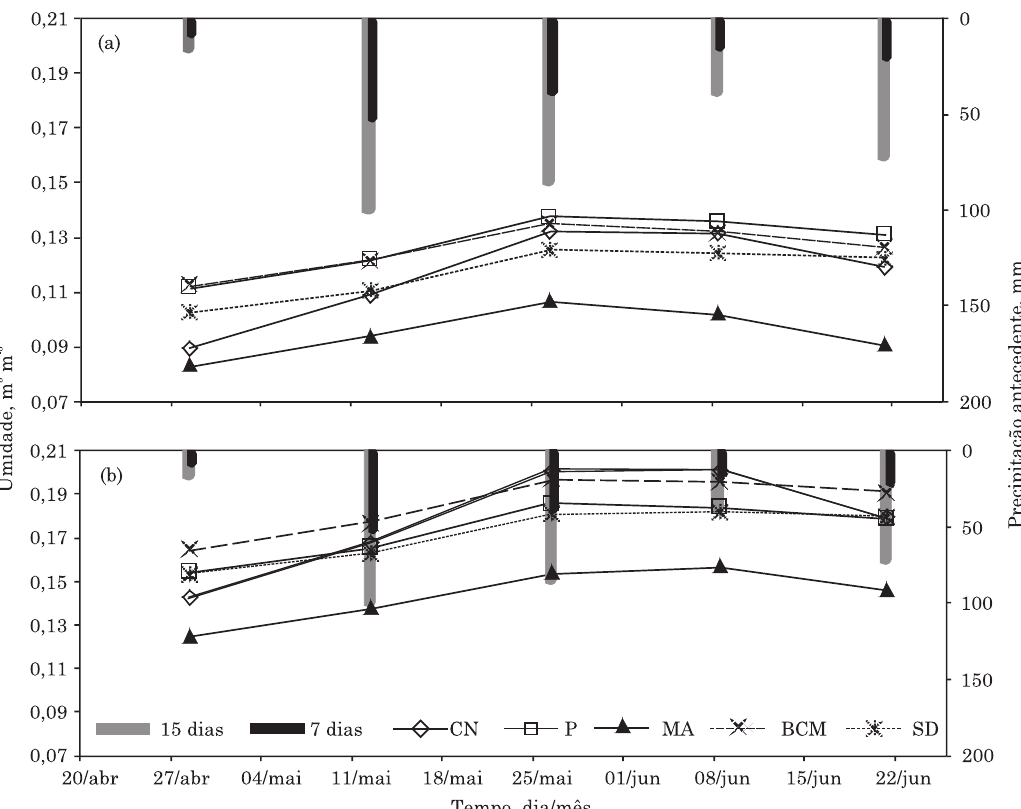
Figura 4. Média móvel da umidade do solo para os tratamentos e precipitação antecedente de 7 e 15 dias, no período de abril a julho de 2011, para as profundidades de 20 cm (a) e 40 cm. (b). CN: cobertura